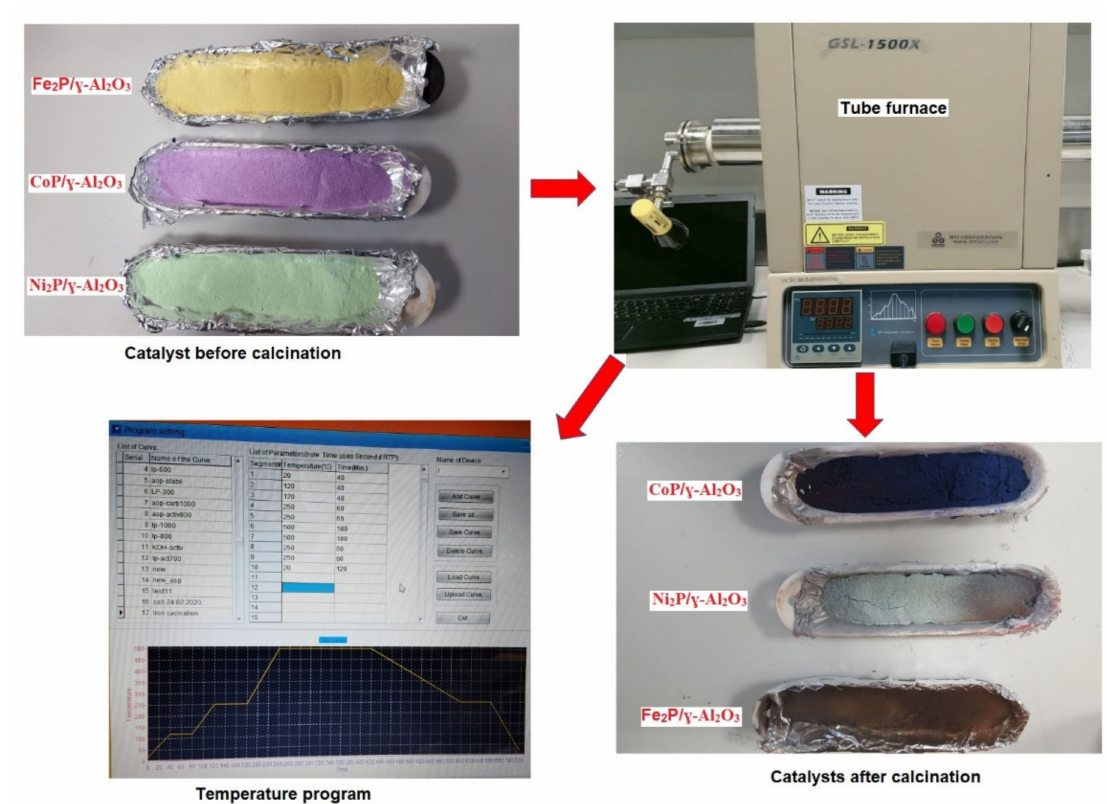
Figure 2. H 2 -TPR profiles of 5 wt.% (a) Ni 2 P/ ɣ -Al 2 O 3 , (b) CoP/ ɣ -Al 2 O 3 , and (c) Fe 2 P/ ɣ -Al 2 O 3 supported catalysts.